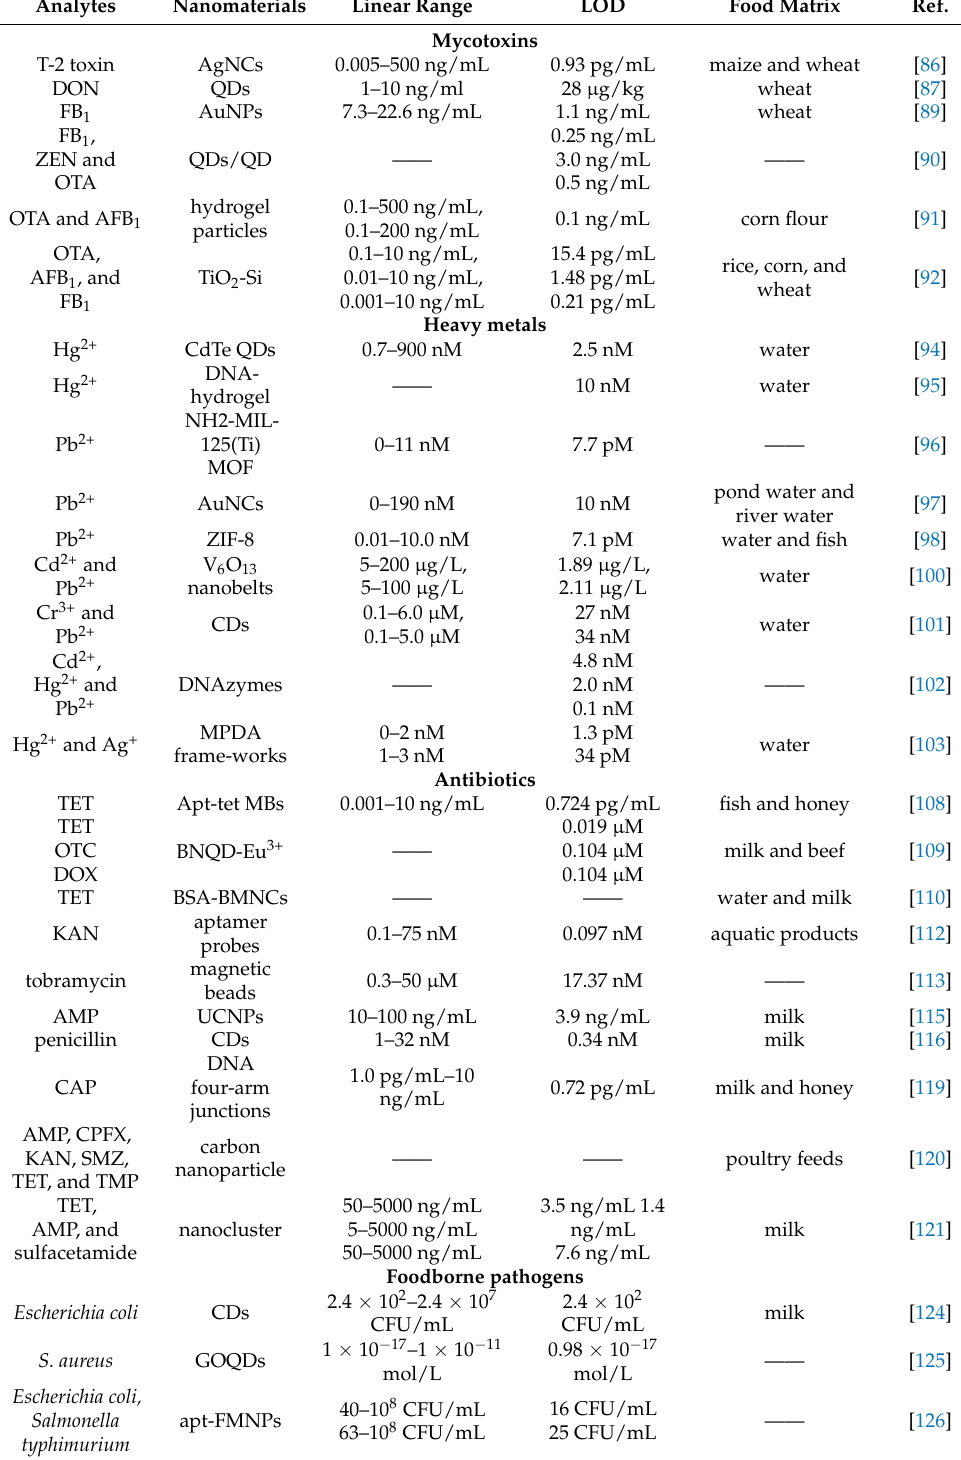
Table 1. Reported Nanomaterials-based fluorescent biosensor for the determination of food contaminants.